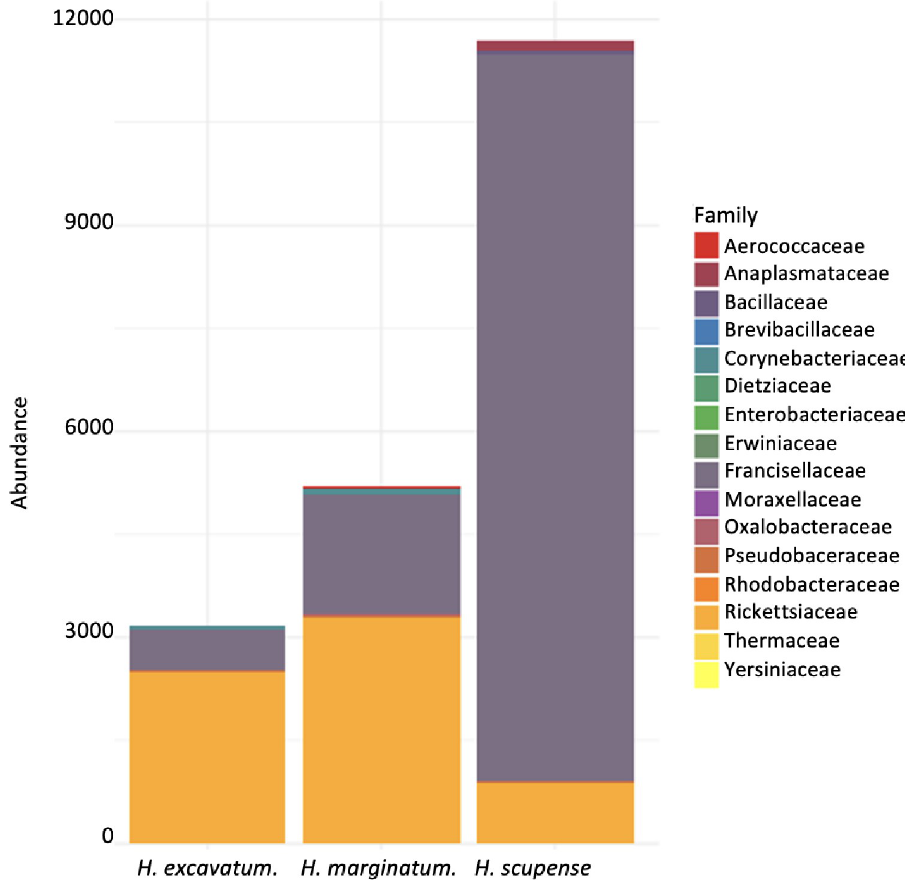
Fig 1. Family level taxonomic composition of Hyalomma excavatum , H . marginatum and H . scupense adult